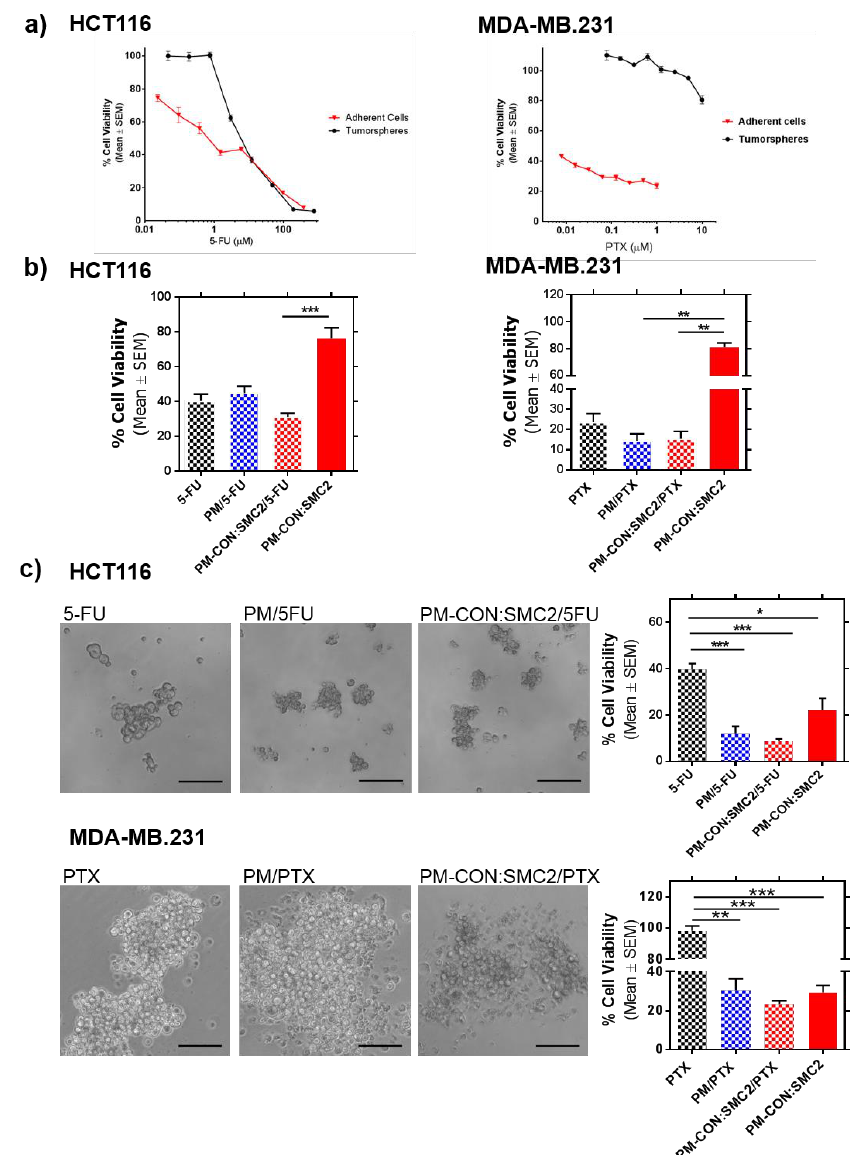
Figure 6. PM-Ab-SMC2 / Drug combination. ( a ) Cell viability curves of HCT116 and MDA-MB-231 cells cultured in adherent culture or as tumorspheres after the incubation of increasing concentrations of 5-FU for HCT116 (from 0.023 µ M to 384.40 µ M for adherent conditions and from 0.047 µ M to 768.86 µ M for low-attachment conditions) and PTX for MDA-MB-231 cells (from 0.0078 µ M to 1 µ M for adherent growing cells and from 0.078 µ M to 10 µ M for tumorspheres). ( b ) Efficacy on adherent cells of the free drug (48 µ M of 5-FU and 1 µ M of PTX), encapsulated drug into PM (0.625 mg / mL for HCT116 and 5 mg / mL for MDA-MB-231 of polymer) and encapsulated drug into PM-CON:SMC2 (4.11 µ g / mL for HCT116 and 32.9 µ g / mL for MDA-MB-231 of Ab-SMC2). ( c ) Left panels, microscopy images of HCT116 and MDA-MB-231 spheres after treatment with the free drug (3.84 µ M of 5-FU and 0.1 µ M of PTX), PM / Drug (1 mg / mL of polymer) and PM-CON:SMC2 / Drug (6.58 µ g / mL of anti SMC2 antibody). Scale bar correspond to 100 µ m. Right panels, sphere formation assay of HCT116 and MDA-MB-231 cells after treatment with the free drug, PM / Drug and PM-CON:SMC2 / Drug. * p < 0.05, ** p < 0.01, *** p < 0.001.